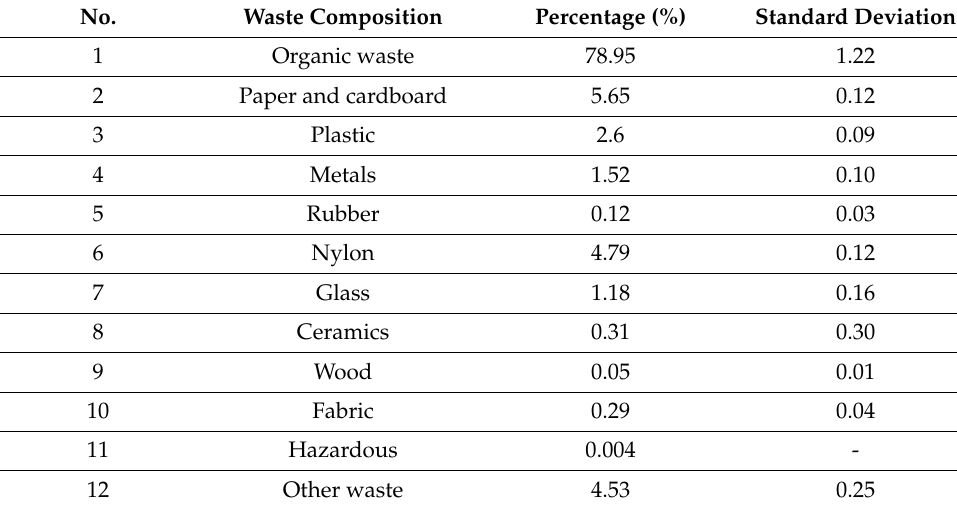
Table 3. Household solid waste composition in Hanoi